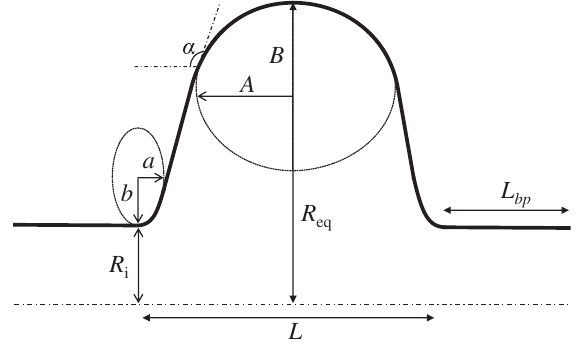
FIG. 1. The parametrization of the cross section of a single-cell elliptical cavity. The variables R eq , L , A , B , a , b , and R i parametrize the cell, and L is the beam pipe bp